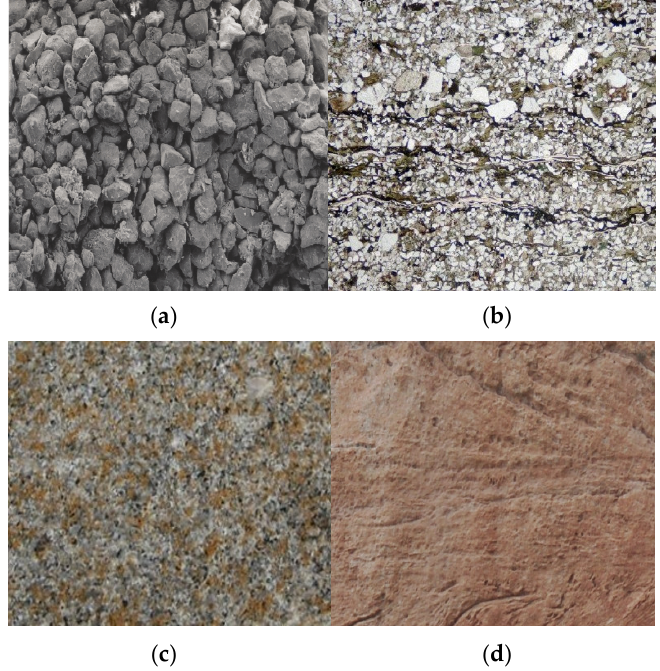
Figure 7. Images of sandstone as seen ( a ) from the SEM (50 µ m); ( b ) from a polarizing microscope, (3.5 mm); ( c ) from a hand specimen (with length approximately 5 cm); and ( d ) from a field outcrop (1 m). For more information on the source, description and processing of the images, see